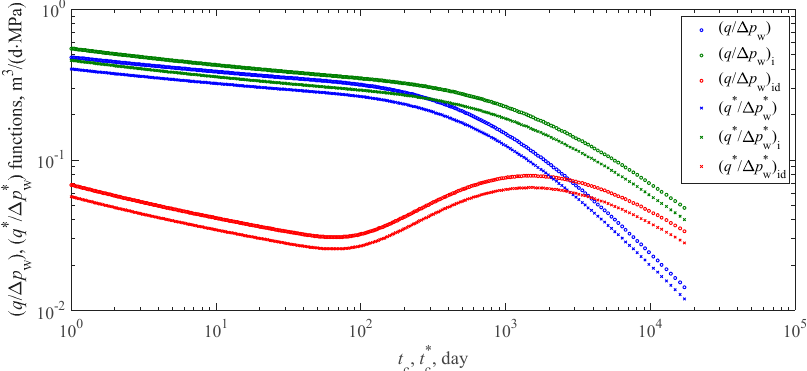
50 MPa Δ = p . w Figure 6. Normalized rate functions and modified normalized rate functions for CPP case of